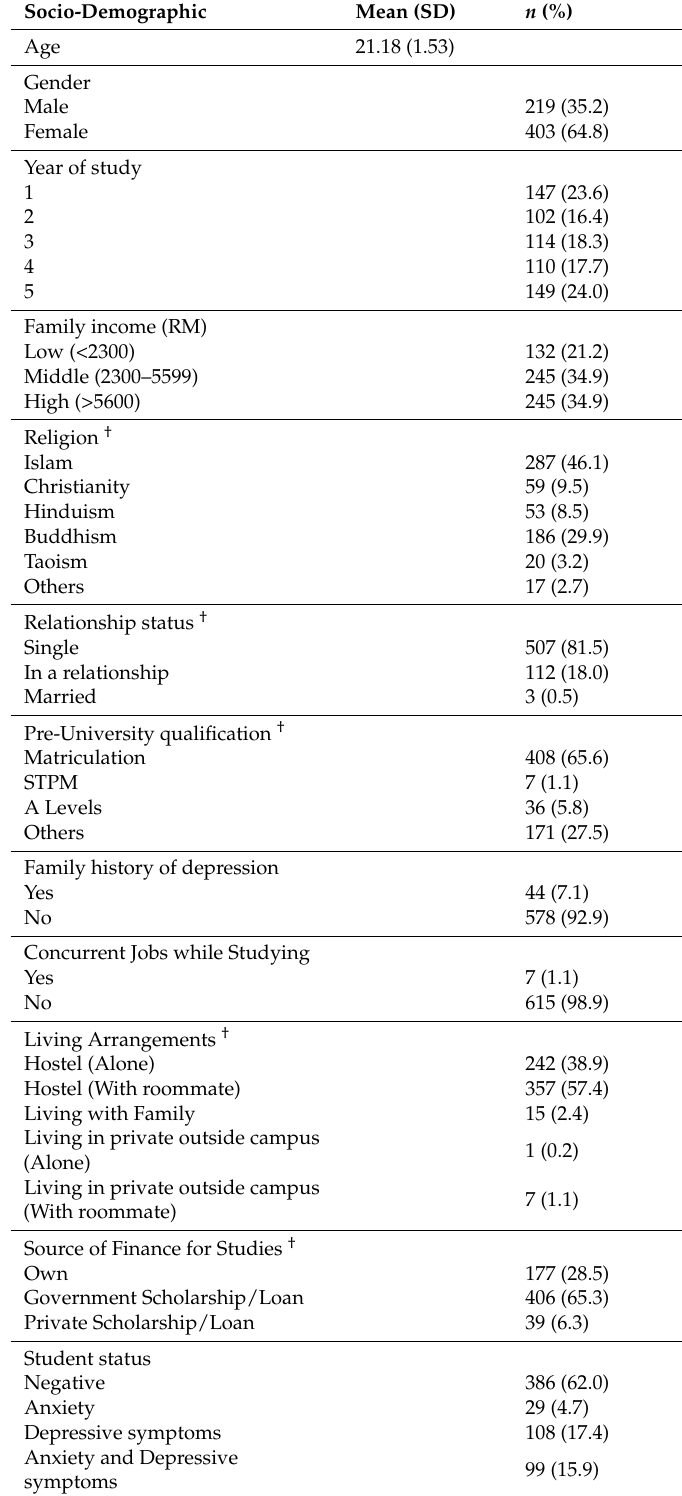
Table 1. Socio-demographic characteristics and mental health status of medical students ( n =